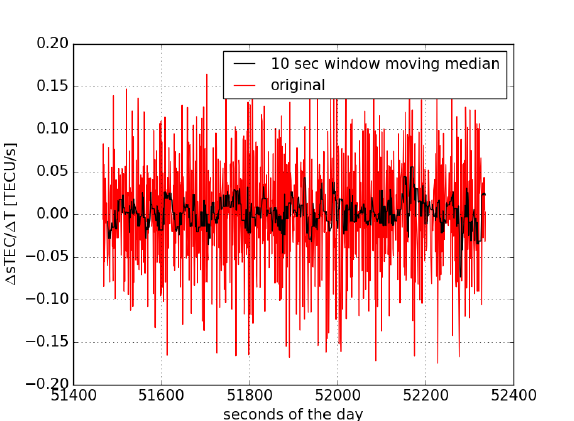
Figure 12. Trends of the original G24 Xiaomi Mi8 ∆ sTEC / ∆ t series and of the one after using a 10 s window moving median depicted respectively in red and black.